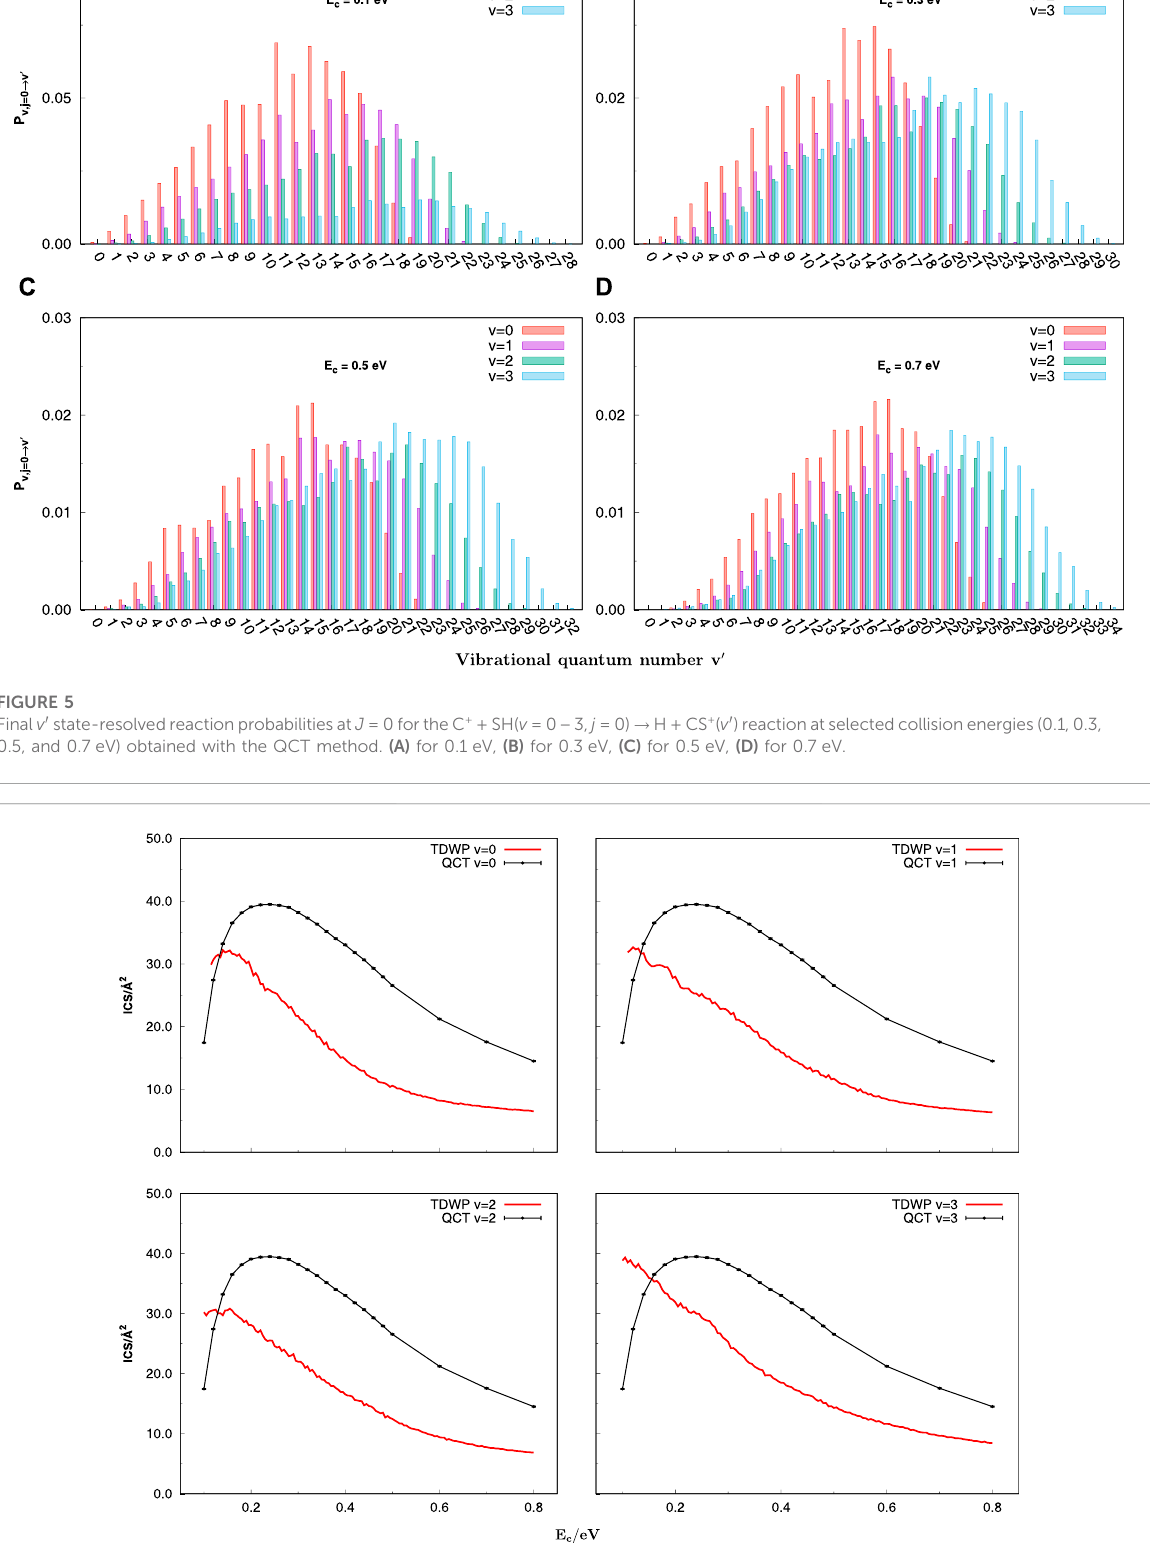
FIGURE 6 IntegralcrosssectionsasafunctionofcollisionenergyfortheC + +SH( v =0 − 3, j =0) → H+CS + ( v ′ )reactionobtainedwiththeTDWPandQCTmethodologies.